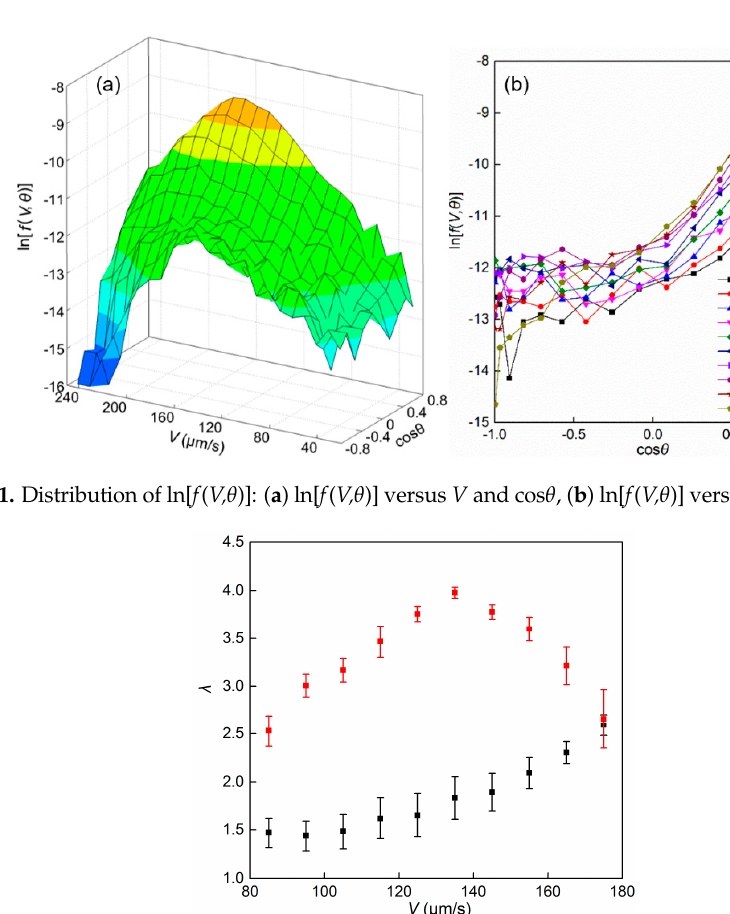
Figure 12. λ at different values of V with the red bars corresponding to the values of all cells in tests and the black bars corresponding to the values of cells that only walk upwards.